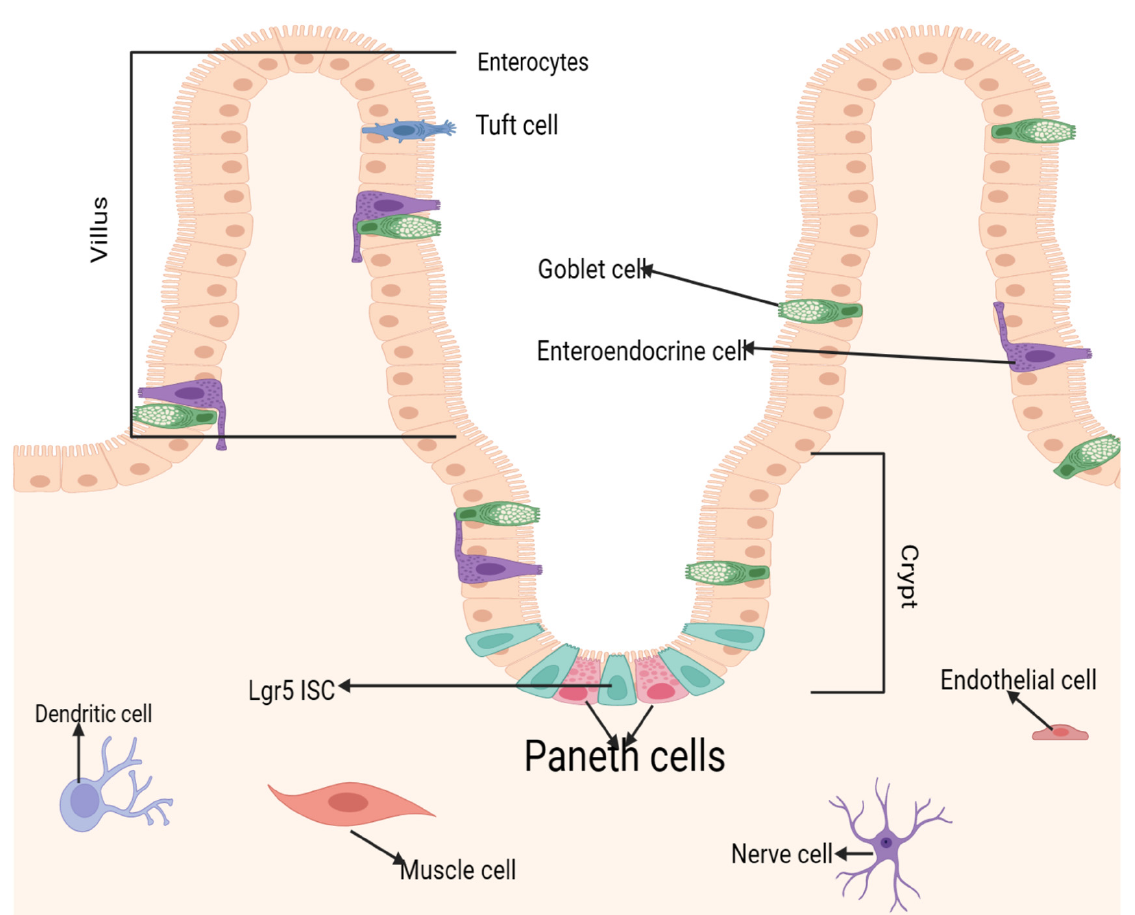
Figure 1. Schematic illustration of the structure of the intestinal crypt showing Lgr5 + ISCs in intimate contact with the Paneth cells at the base of the crypt, enterocytes with microvilli, goblet cells, and enteroendocrine cells. The sketch also shows some of the cells which are critical for the maintenance of normal structure and function of the small intestine that include dendritic cells, endothelial cells, nerve cells, and smooth muscle cells (The illustration was created using BioRender.com).